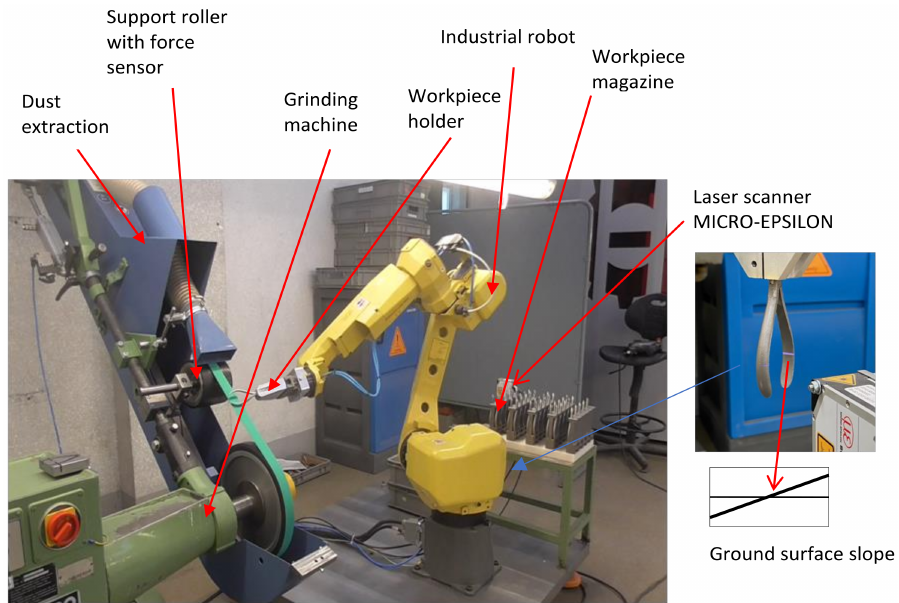
Figure 7. Research stand for belt grinding with the use of an industrial